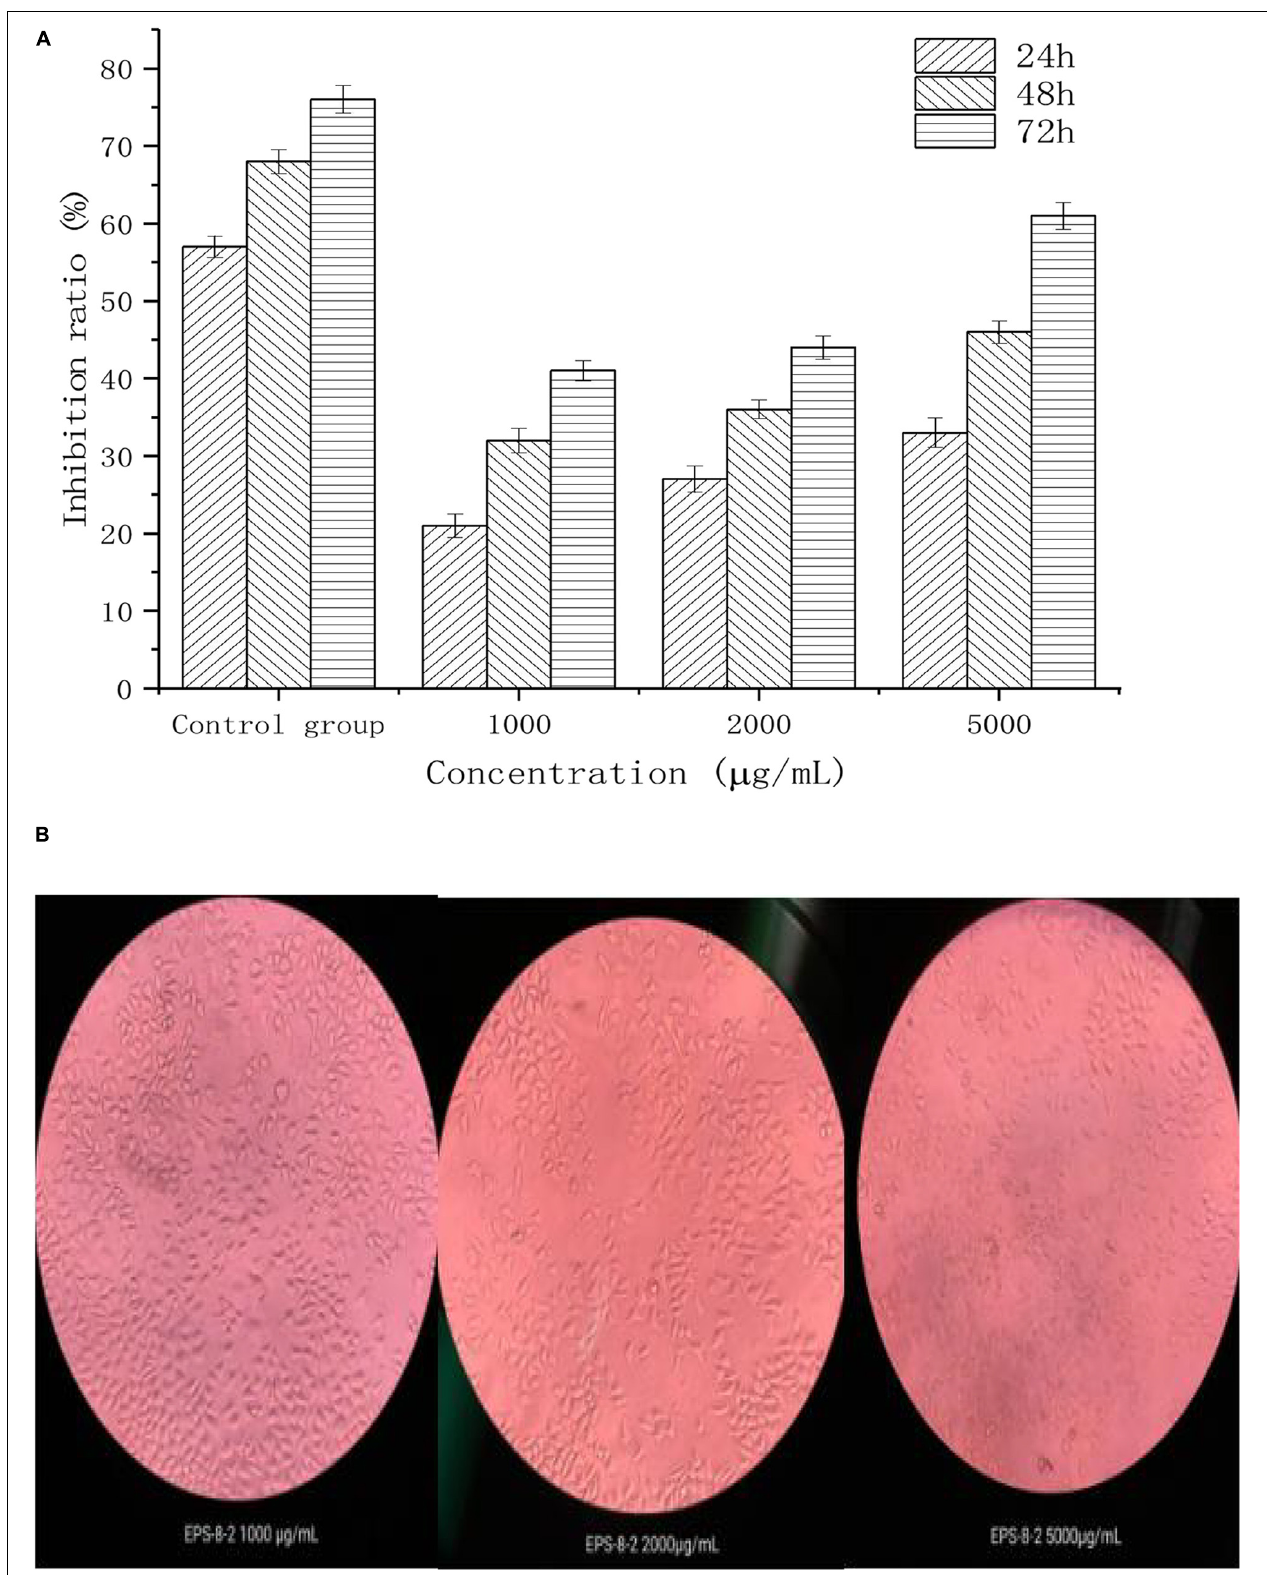
FIGURE 5 | Antitumor effects of EPS-8-2 (A) on HepG-2 cells. All values were expressed as means ± standard deviation (SD) of three replications (B) .